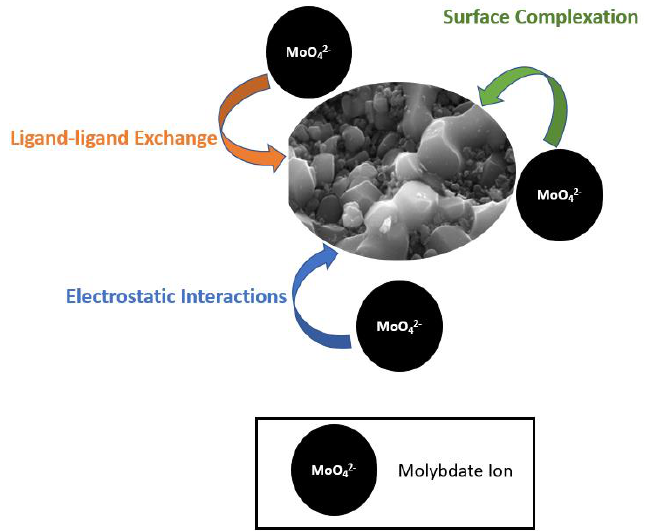
Figure 17. Schematic representation of the possible mechanisms of Mo adsorption by the CDC.